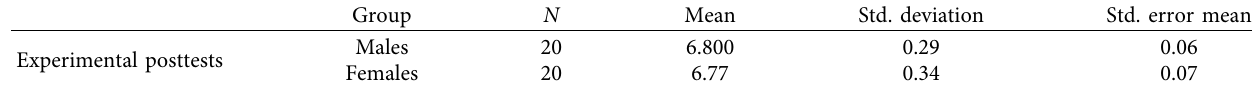
Table 5: Descriptive statistics for the males and females’ posttests.